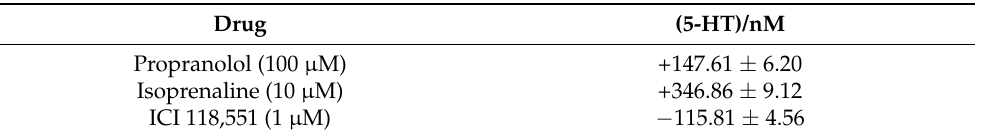
Table 3. Variation of concentrations of 5-HT (nM) in the cellular medium of propranolol, isoprenaline, and ICI 118,551-treated MCF-7 cells, determined by